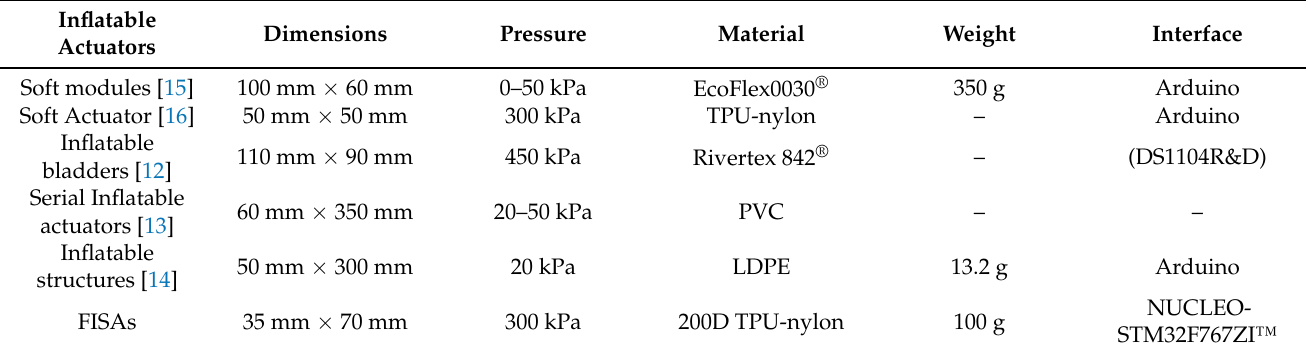
Table 1. FISAs features and comparison with other inflatable structures for rehabilitation